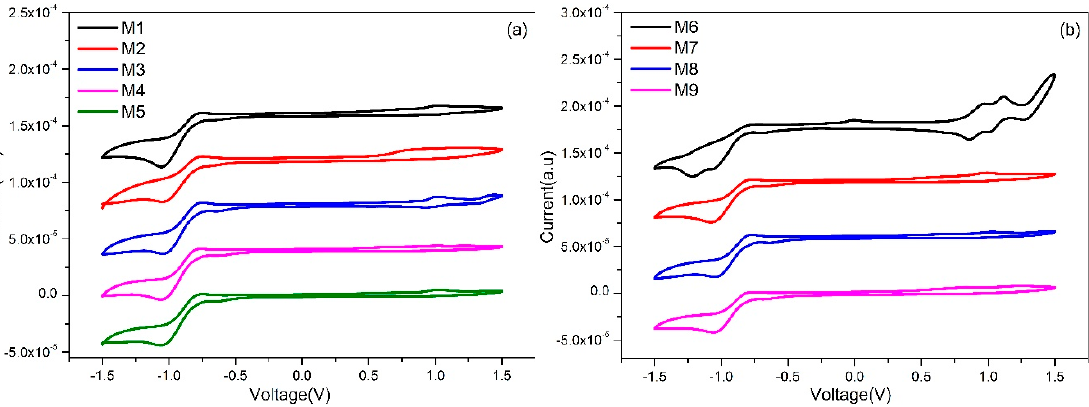
Figure 3. Cyclic voltammograms of meta -substitution phenyl-cored DPP molecules Ms1~5 ( a ) and